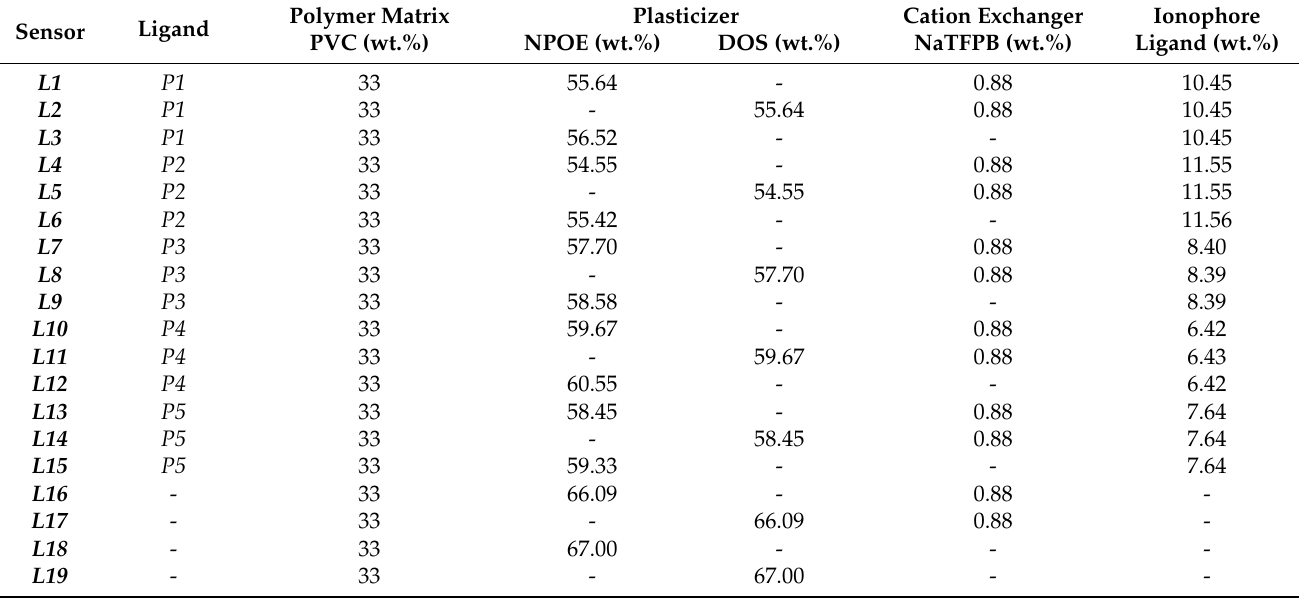
Table 1. Sensor membrane compositions